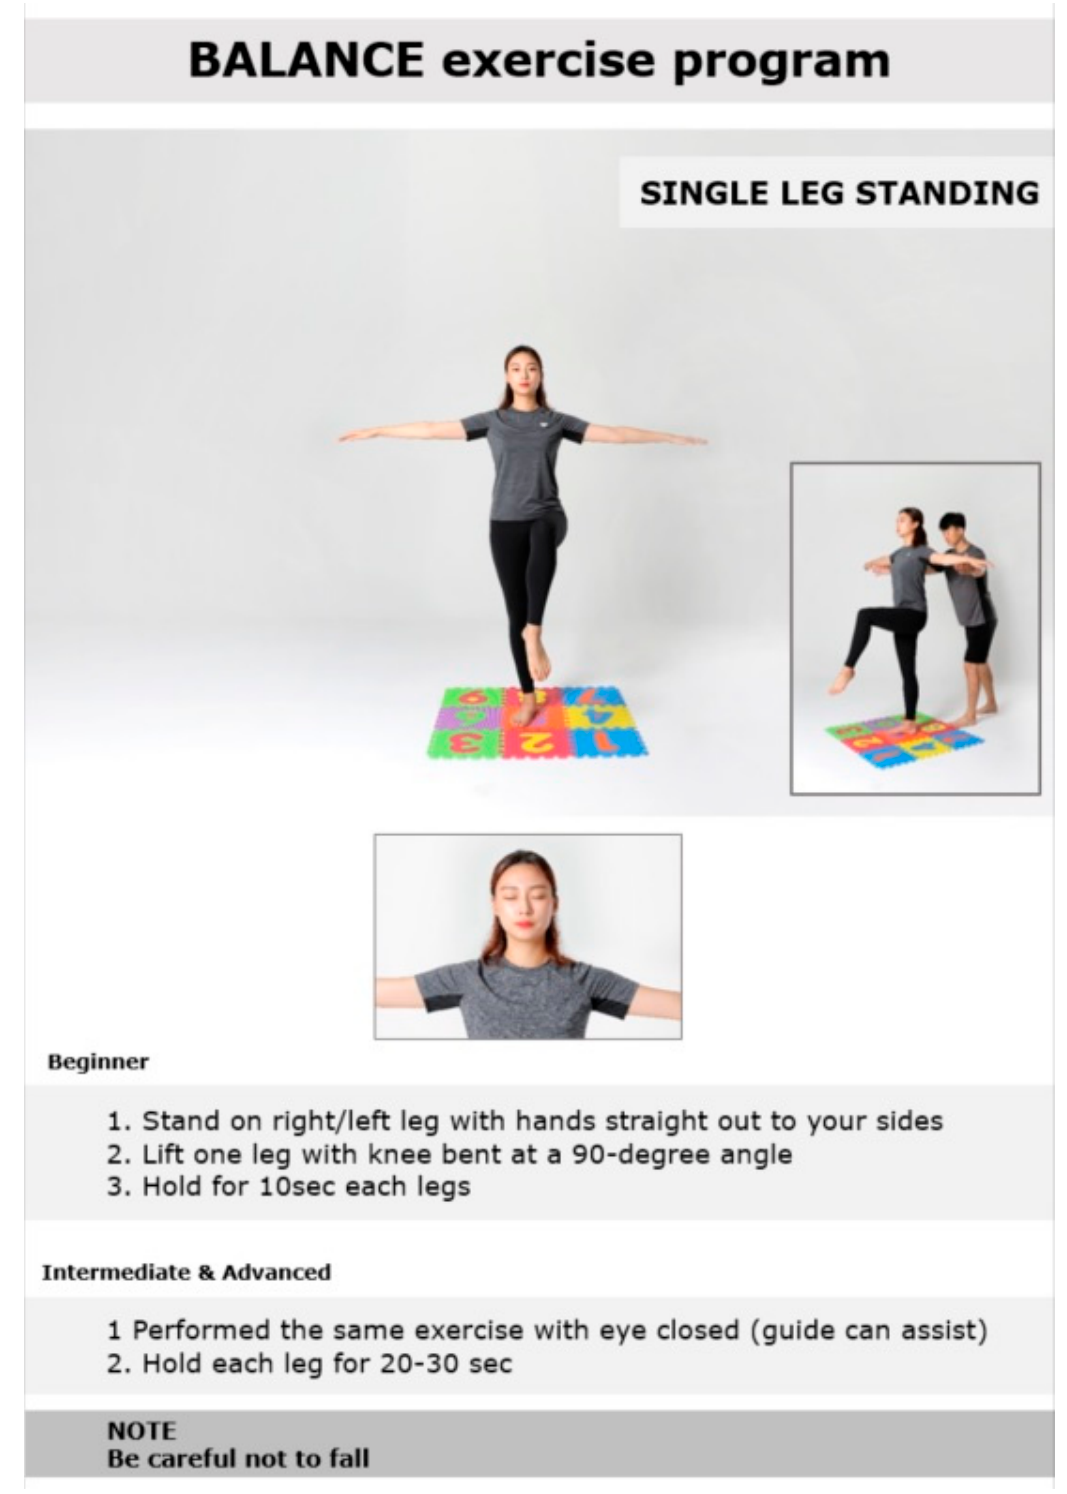
Figure A18. Detailed description and components of each movement in the “Single leg standing” resistance exercise.